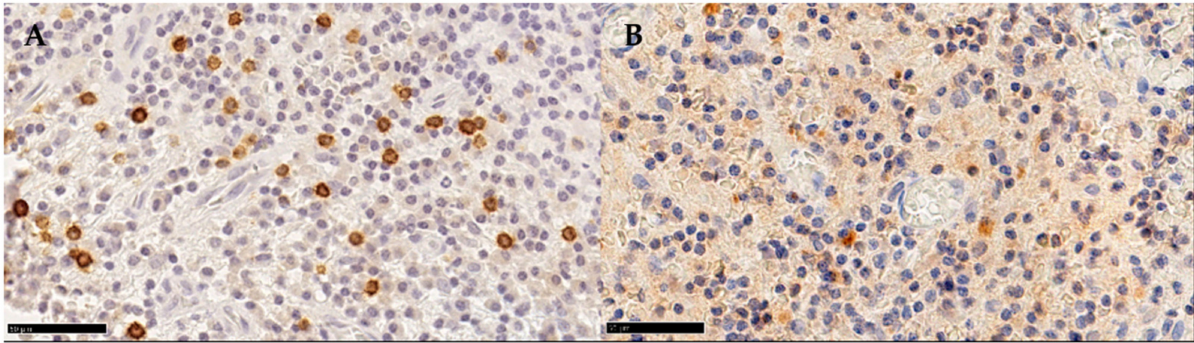
Figure 1. Detail of two CD4+ immunostained slides of PD. Exemplification of a ( A ) GOOD sample and ( B ) NOISE